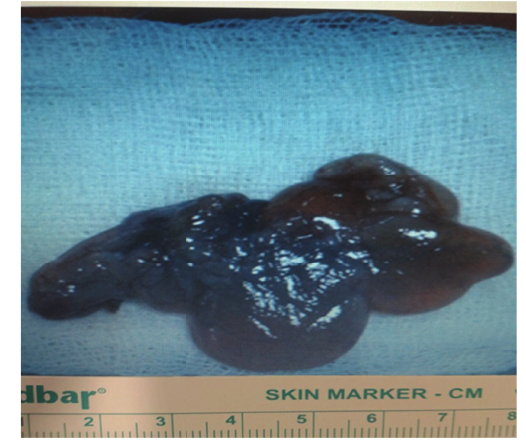
Figure 2: On cystoscopy, a vegetative mass (5 × 6cm in size) at left orifice of bladder that protrudes to bladder through a stalk.